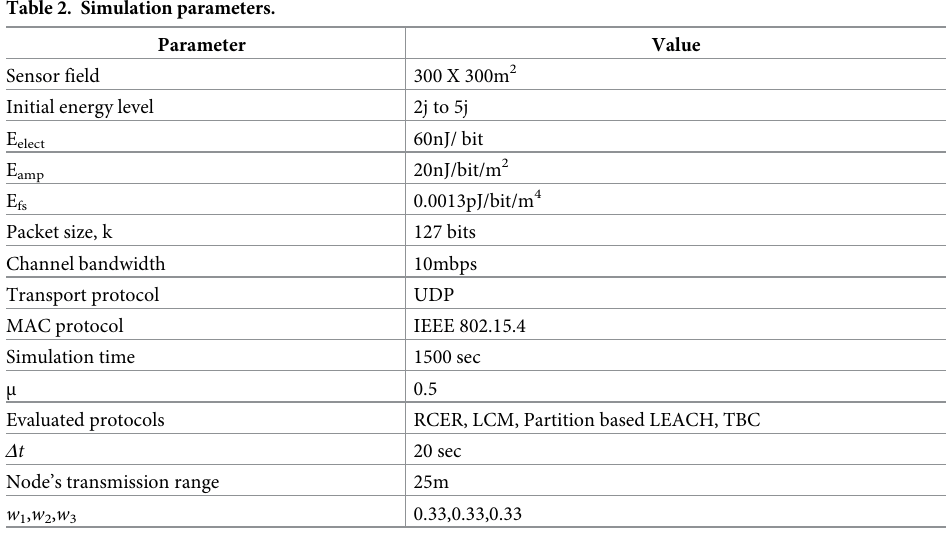
Table 2. Simulation